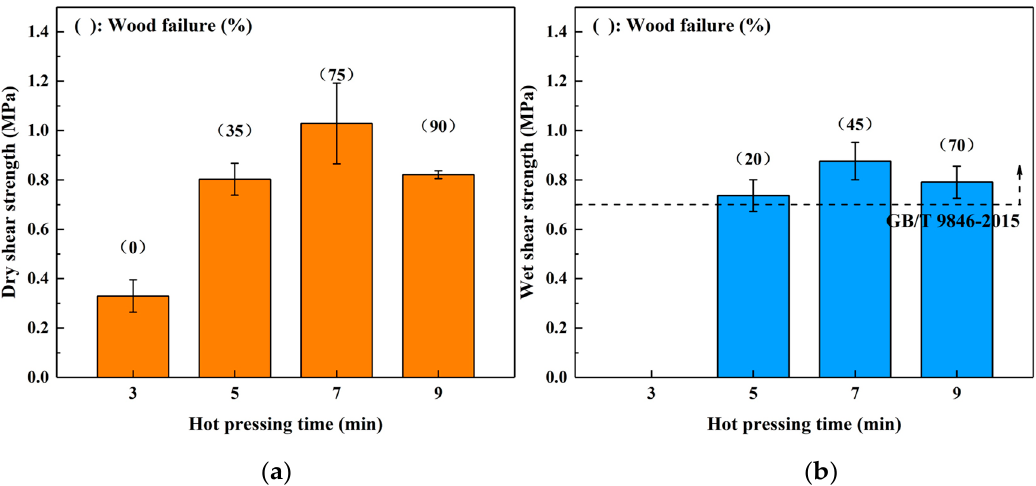
Figure 4. E ff ects of hot pressing time on the bond performance of plywood: ( a ) dry shear strength and ( b ) wet shear strength.